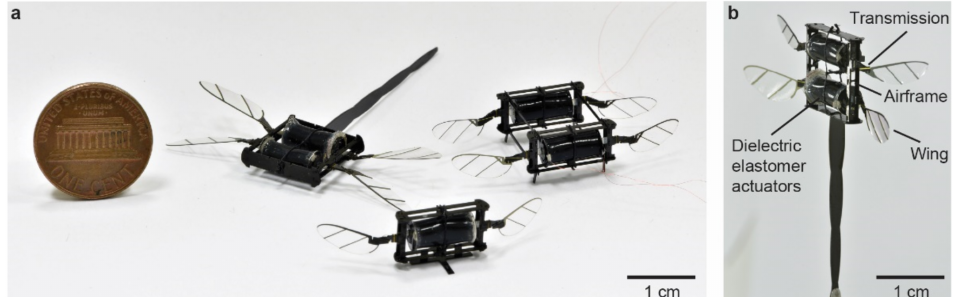
Figure 1. Illustration of insect-scale flapping-wing robots. ( a ) An image showing three insect-scale flapping-wing robots powered by DEAs. In this work, we design and characterize a 317 mg dragonfly- like (left) flapping-wing robot and investigate forewing–hindwing interactions. ( b ) The robot consists of two DEAs, four wings, an airframe, and four sets of transmissions and wing